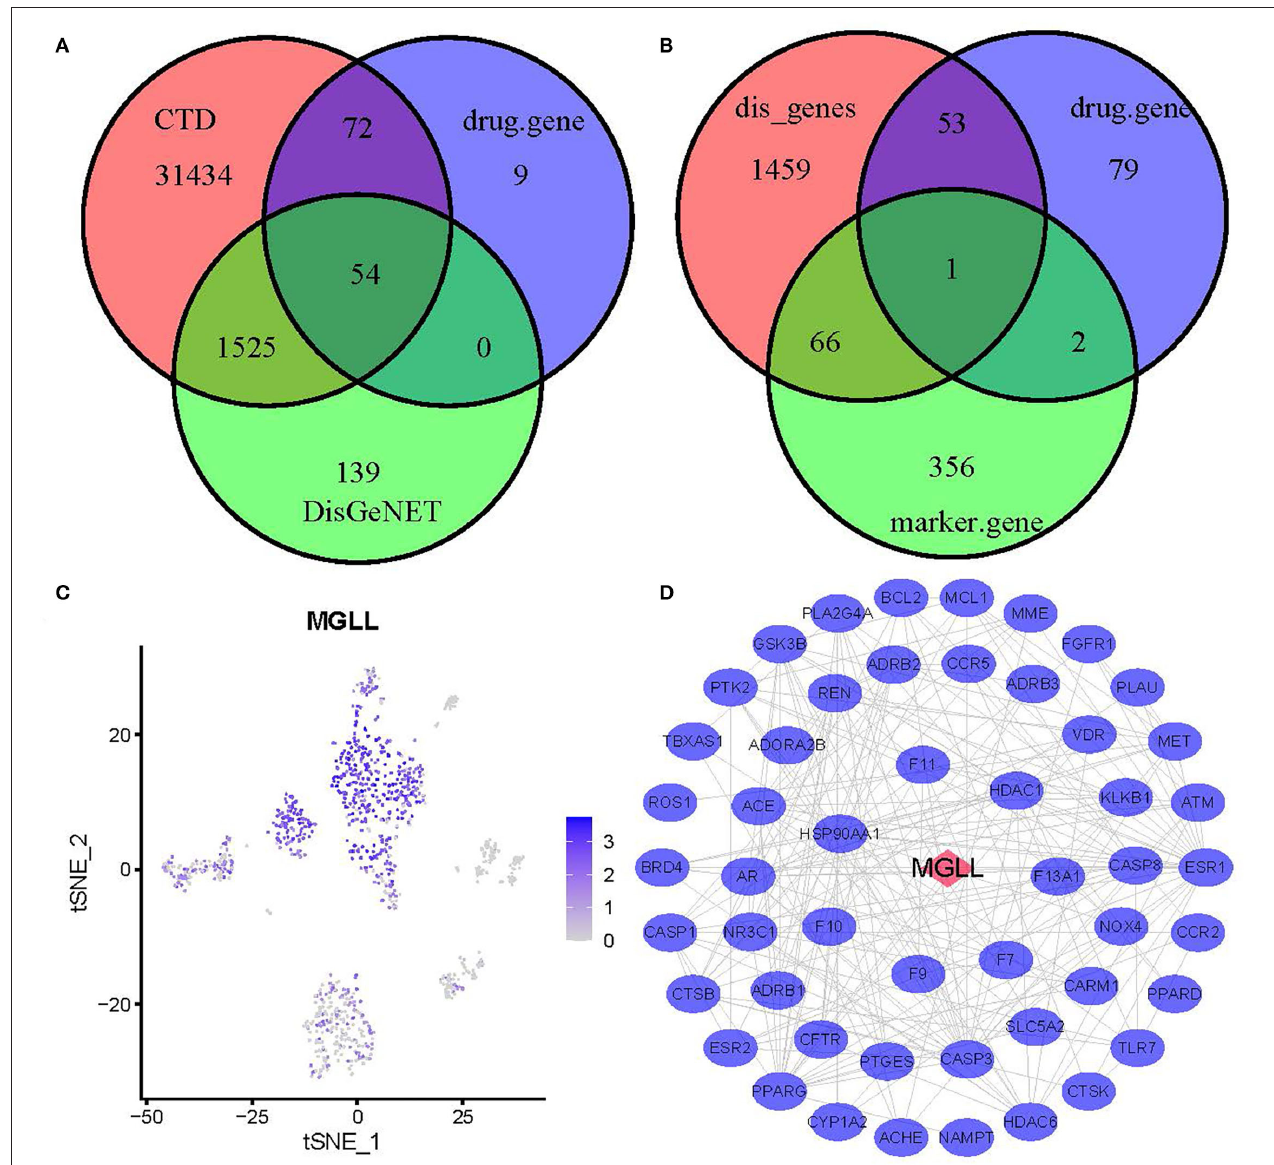
FIGURE 3 | Identification of hub genes. (A) A Venn diagram of target genes associated with 7 common drugs for myocardial infarction and genes associated with myocardial infarction (MI). (B) A Venn diagram of target genes associated with 7 common drugs for MI, genes associated with MI, and marker genes of hematopoietic stem cell. (C) T-distributed Stochastic Neighbor Embedding of MGLL. (D) Protein–protein interaction (PPI) network of 52